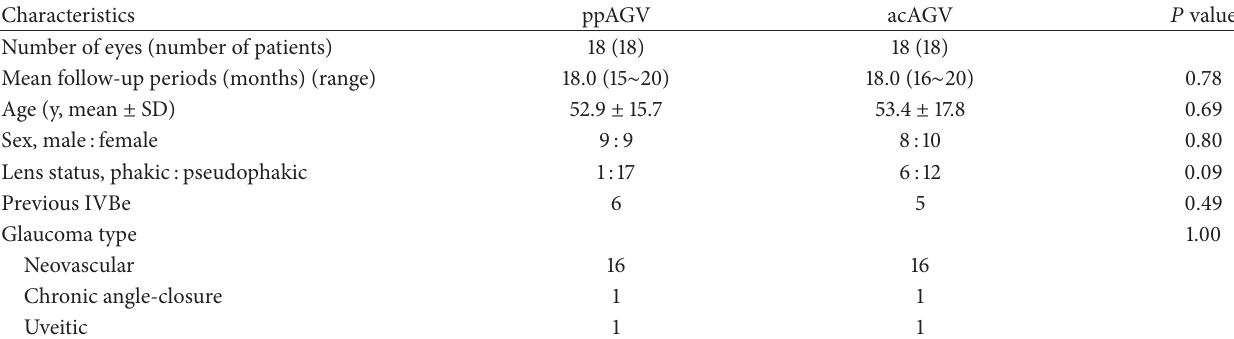
Table 1: Patient demographics.